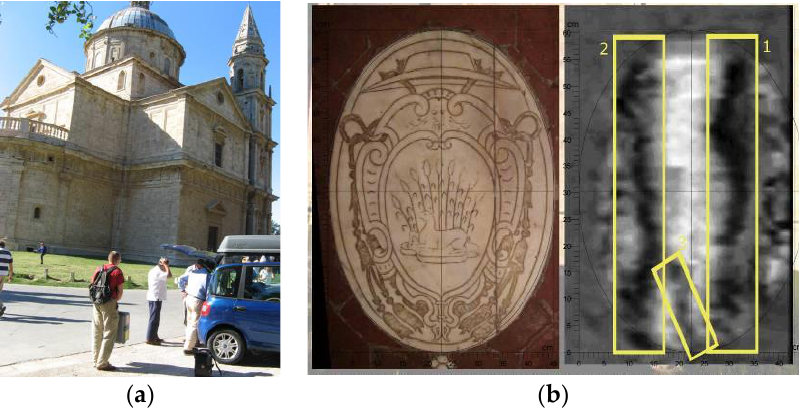
Figure 29. ( a ) The church of San Biaggio and ( b ) side-by-side optical and MW images of the medallion. The dark feature labeled 3 matches a barely visible hairline crack in the marble.